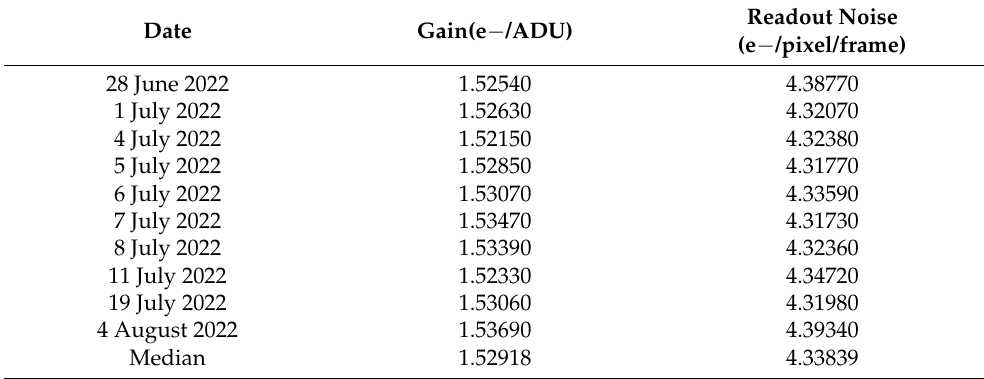
Table 4. The 10 times gain and readout noise test results of the camera in the same environment.